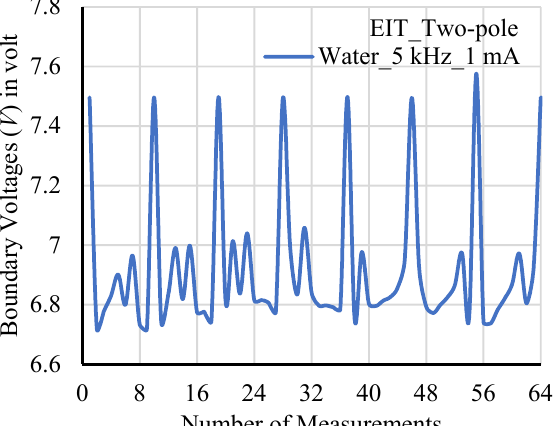
Figure 7. The boundary voltages for a homogeneous media (water) at 5 kHz, and 1 mA signal considering two-pole measurements in one layer of EIT domain.